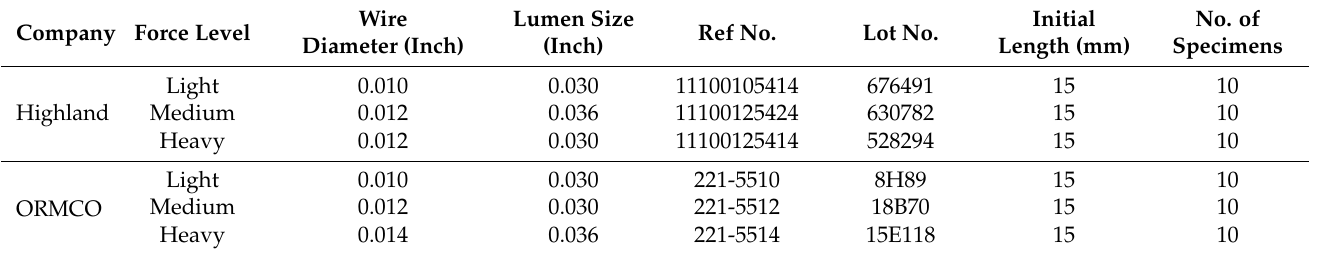
Table 1. Dimensions of commercial NiTi open-coil springs obtained for mechanical